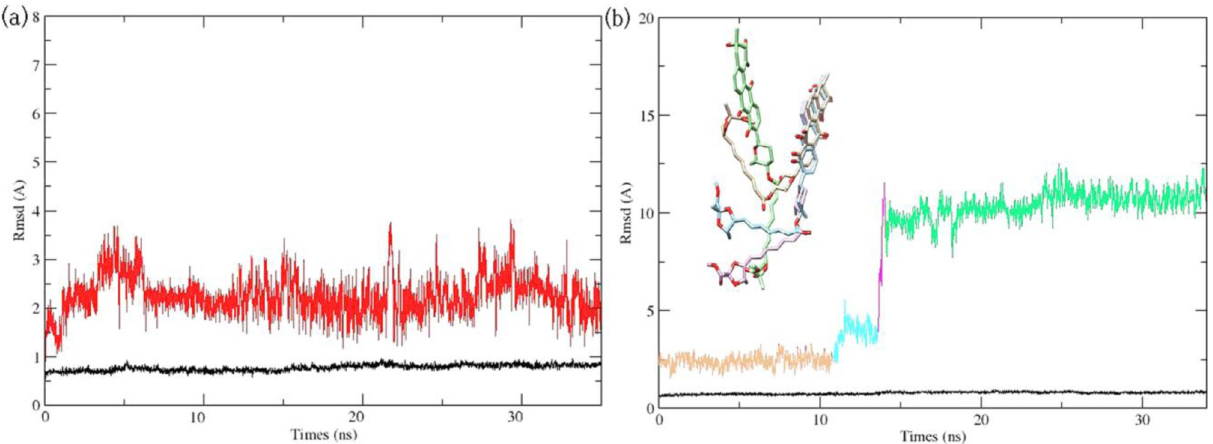
Fig 7. Root-Mean-Square Deviation (RMSD) in Molecular Dynamics (MD) simulations. (a) RMSD of protein backbones (black lines) and waldiomycin (red lines). (b) RMSD of protein backbones (in black lines) and of waldiomycin methyl ester (in similar color) with the four orientations of waldiomycin methyl ester through the MD simulation time intervals. 0–11 ns (beige color), 11–14 ns (cyan color), 14–14.5 ns (pink color), and 14.5–35 ns (green color).